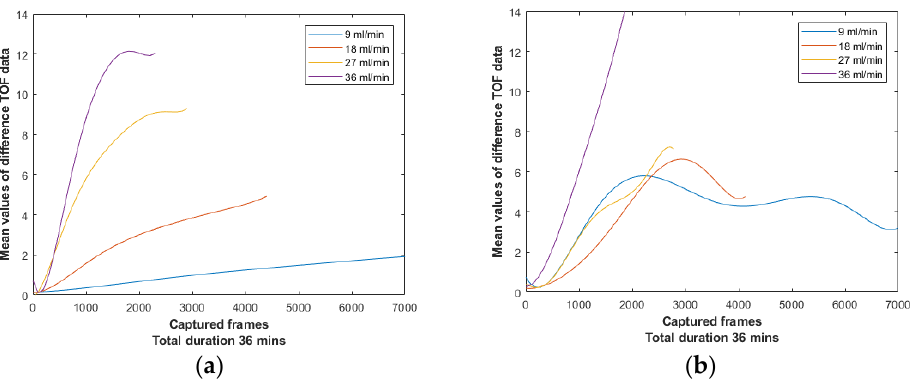
Figure 13. ( a ) Plot of all frame’s mean value of difference data for non-stirring cases. ( b ) Plot of all frame’s mean value of difference data for stirring cases using a IKA Midi 1 digital magnetic stirrer at 100 rpm.